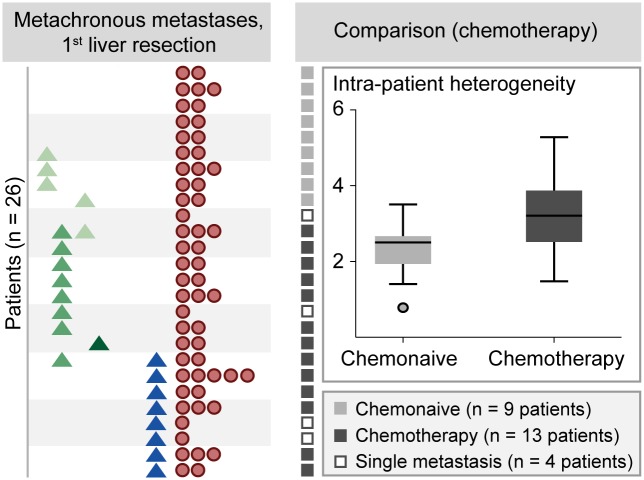
High intra-patient inter-metastatic genetic heterogeneity after chemotherapy exposure.Twenty-two of the 26 patients (vertically in the left panel) with metachronous metastases had two or more liver deposits (horizontally in the left panel) at first liver resection (the symbols are the same as described in Fig 1). The right panel shows the intra-patient inter-metastatic genetic heterogeneity in chemonaïve patients (n = 9; indicated by light grey boxes in the left part of the right panel) versus patients treated with chemotherapy (n = 13; indicated by dark grey boxes), respectively, demonstrating higher intra-patient inter-metastatic heterogeneity after chemotherapy exposure (P = 0.03 by independent samples t-test; however, not statistically significant after correcting for multiple testing).